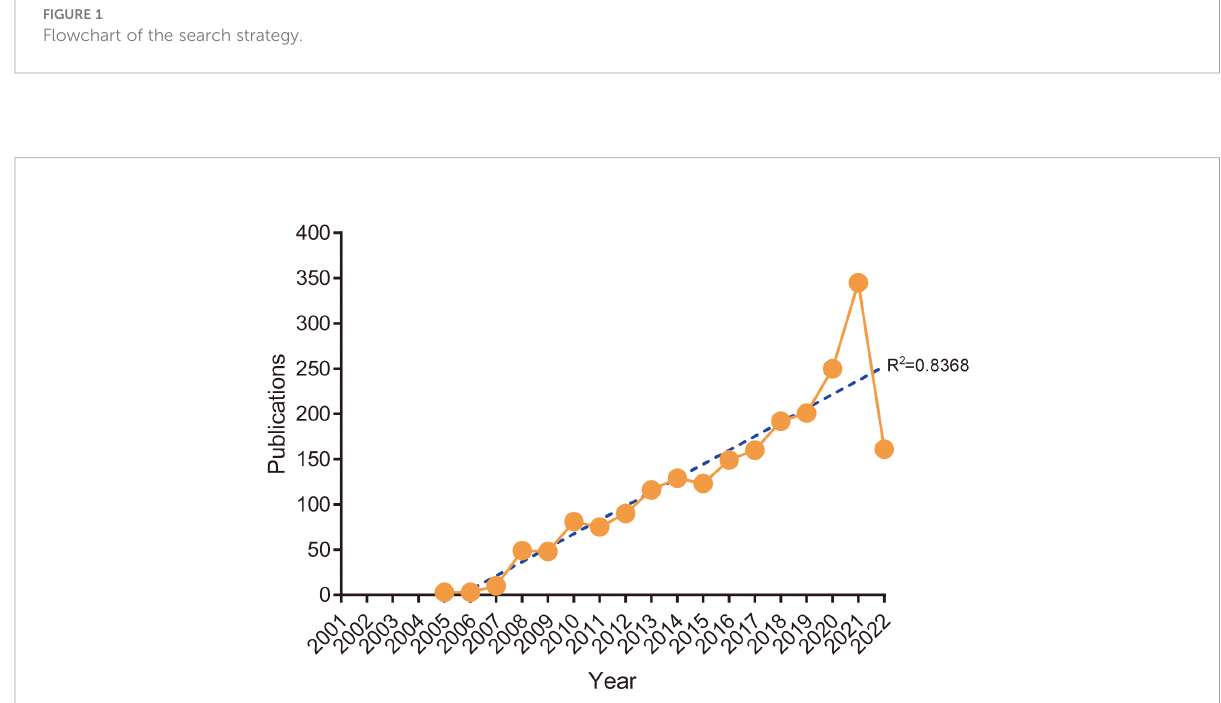
FIGURE 2 Annual trends of global publications.